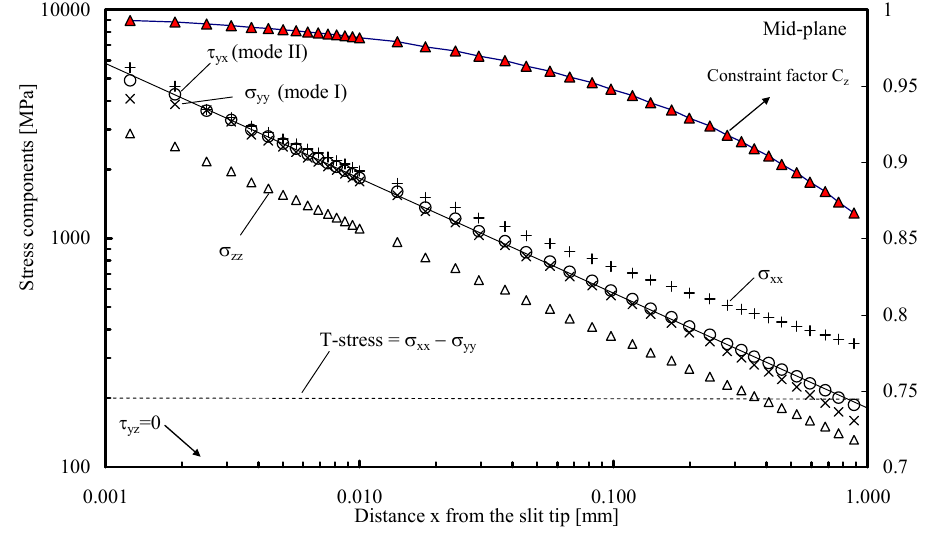
Figura 11: Campi di tensione nel piano medio in funzione della distanza x (Modello trimensionale;